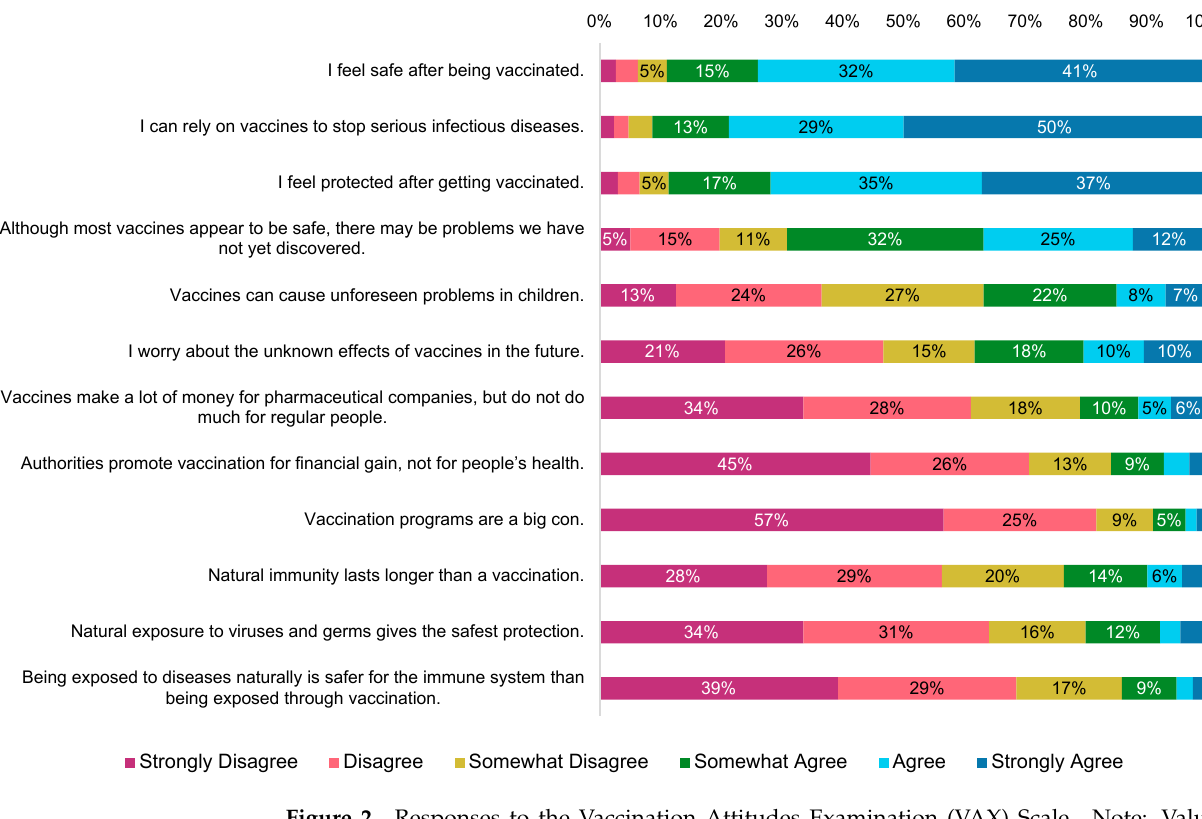
Figure 2. Responses to the Vaccination Attitudes Examination (VAX) Scale. Note: Values are represented as a percentage of the overall total ( n = 334), and data labels for response values lower than 5% have been excluded from this figure. Given the reverse directionality of responses for the first three items, they were reverse-coded when calculating the overall VAX scale score, but show the original responses here.